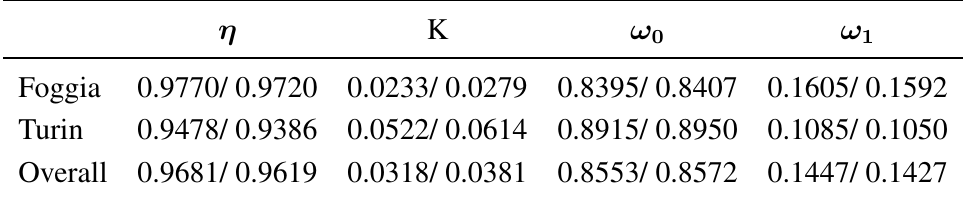
Table 2. Storm identification evaluation; mean values of (cid:17) , K, ! form of graythresh/ThreshGW up to 4 decimal places.